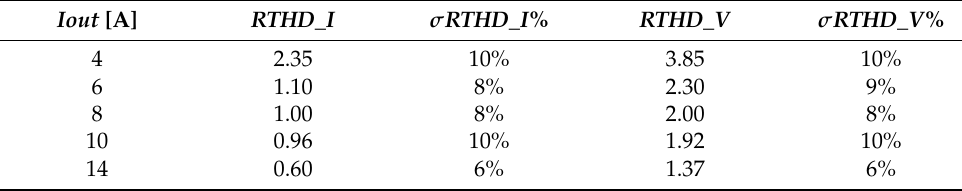
Figure 12. Link between harmonics of current on AC ( Iin ) and DC ( Iout ) sides. Table 4. Experimental values of RTHD_I and RTHD_V against Iout